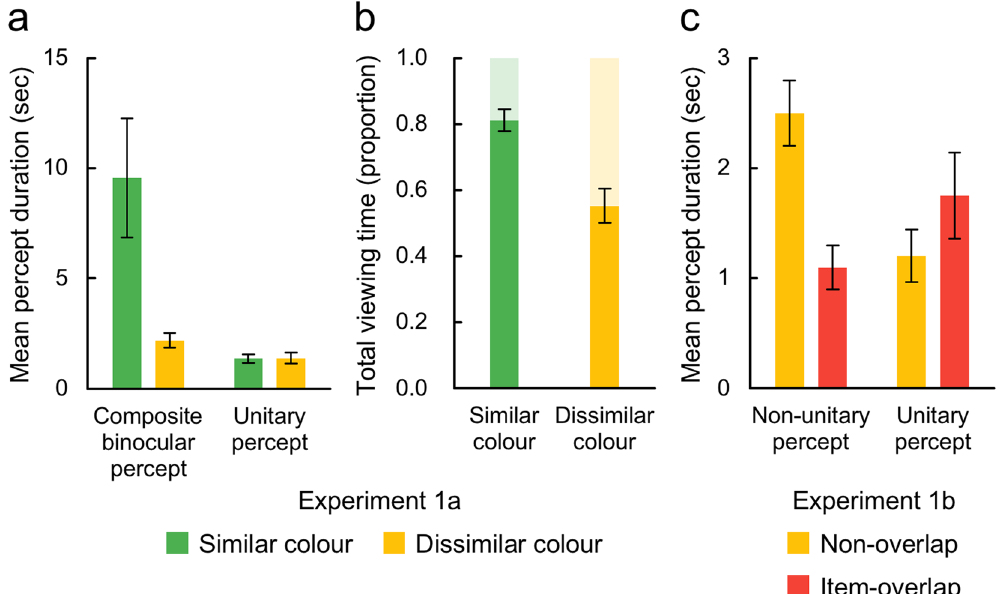
Figure 3. The mean duration of composite binocular percept (CBP) and unitary percept in Experiment 1a are plotted in ( a ). The proportions of the total viewing time of CBP are plotted in ( b ). The proportions of the total viewing time of unitary percept are complementary to those of CBP, and depicted as shaded bars over the solid bars. The mean duration of non-unitary and unitary percepts in Experiment 1b are plotted in ( c ). As the non- overlap condition in ( c ) and the dissimilar colour condition in ( a ) tested almost the same stimuli, their mean durations are similar. In all graphs, error bars indicate the standard error of mean.